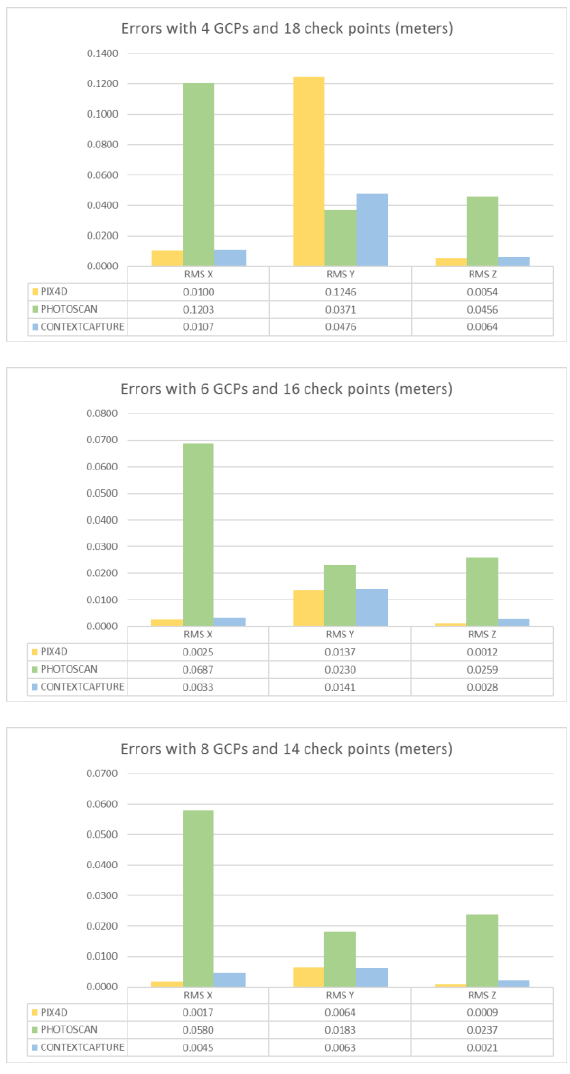
Figure 4. Metric accuracy achieved by different software with different control point / check point